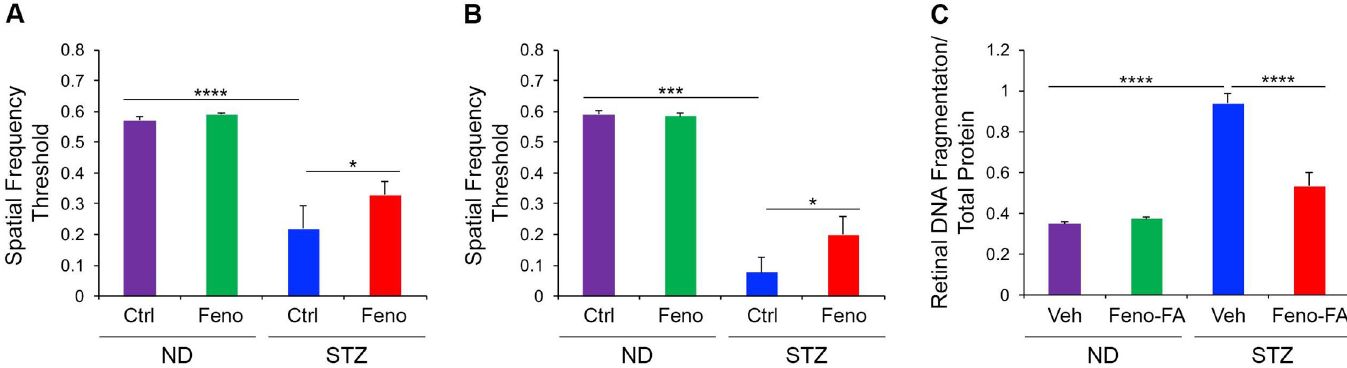
Fig 1. Neuroprotective effects of PPAR α activation in diabetic retinopathy. (A-B) Optokinetic tracking in streptozotocin (STZ)-induced type 1 diabetic Brown Norway rats revealed that visual function, as detected by spatial frequency threshold, declined at (A) 8 weeks and (B) 12 weeks diabetic relative to non-diabetic (ND) rats, and was partially restored by oral treatment with PPAR α agonist fenofibrate (Feno) (ND-Ctrl n = 6; ND-Feno n = 5; STZ-ctrl n = 8; STZ-Feno n = 7 rats) (C) DNA fragmentation ELISA revealed that total retinal apoptosis was increased in diabetic Sprague Dawley rats at 4 weeks diabetic, and was decreased by one week daily intraperitoneal injection of fenofibric acid (Feno-FA) relative to vehicle (Veh, DMSO)-injected rats (ND-Veh n = 13; ND-Feno-FA n = 18; STZ-Veh n = 17; STZ-Feno-FA n = 21 retinas). Data are expressed as mean ± SEM. � p � 0.05; ��� p � 0.001, ���� p � 0.0001, one-way ANOVA with Tukey’s post-hoc comparison.